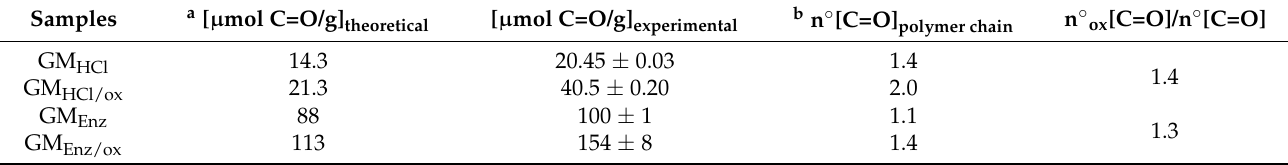
a Theoretical µ mol of carbonyl groups per g of polysaccharide (corresponding to the reducing ends) calculated using the number average molecular weight ( M n ) of each sample. [ µ mol C=O/g] theoretical = [Monomers] tot /DP n , [Monomers] tot = [(m sample (g)* Purity (%)/V sample (L))/m 0 ] and DP n = M n /m 0 , where m 0 is the repeating unit molar mass (162.14 g/mol) and M n (g/mol) is the number average